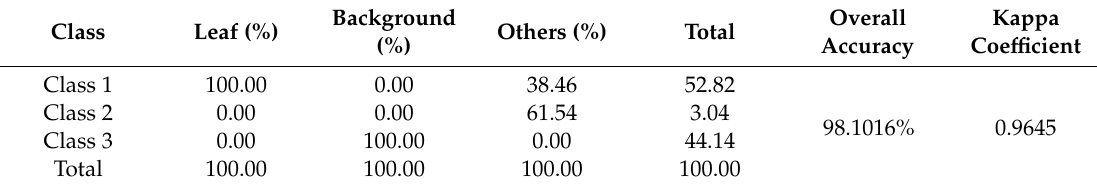
Table 7. Classification accuracy evaluation of restored tilting images.